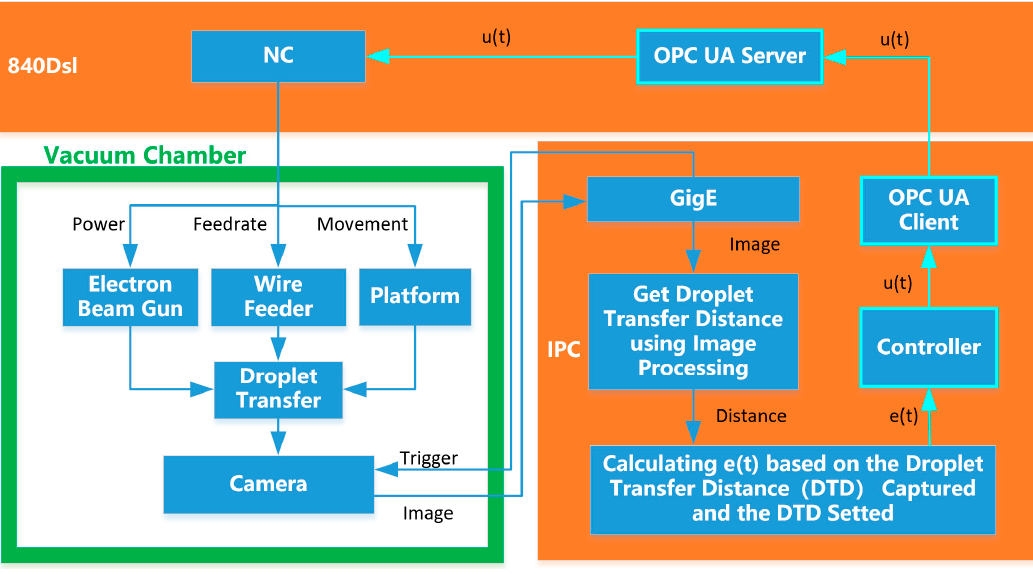
Figure 8. Flow chart of the measurement system. Figure 10. Flow chart of the measurement system.